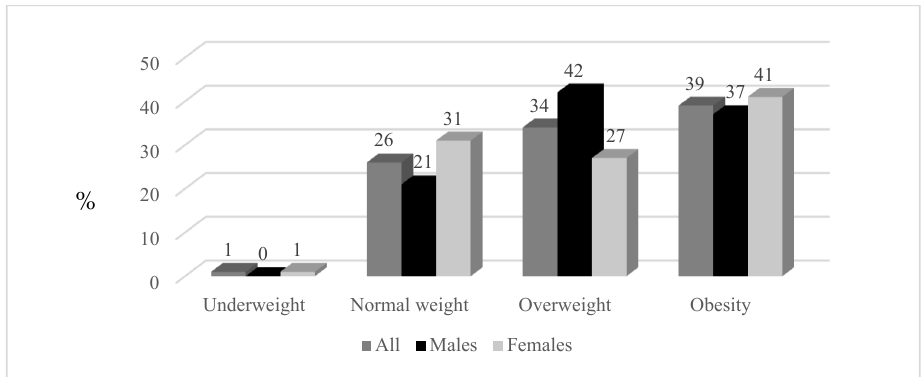
Figure 2. Percentage (%) scores for BMI categories.